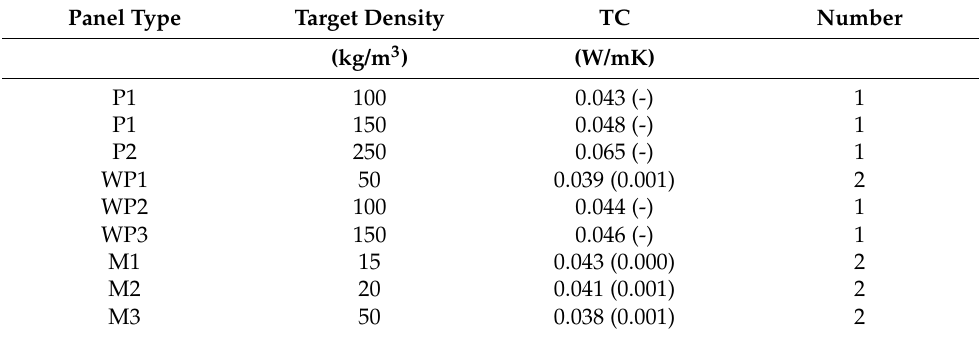
Table 6. Thermal conductivity (SD in